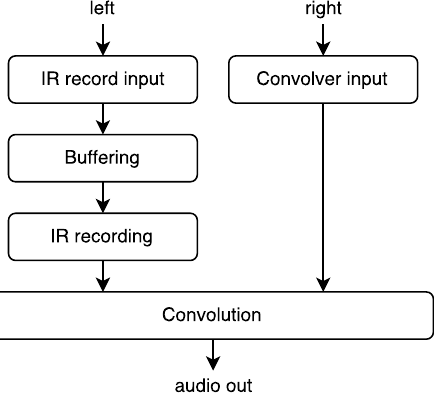
Figure 12. Liveconvolver instrument